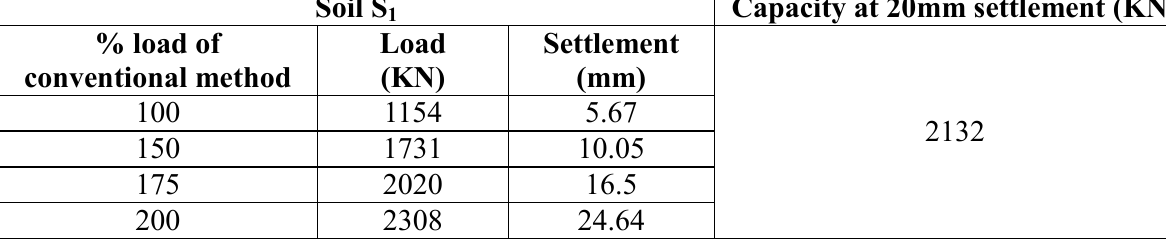
Settlements of D single pile under different loads to find capacity. [Hardening Soil Model]. 600